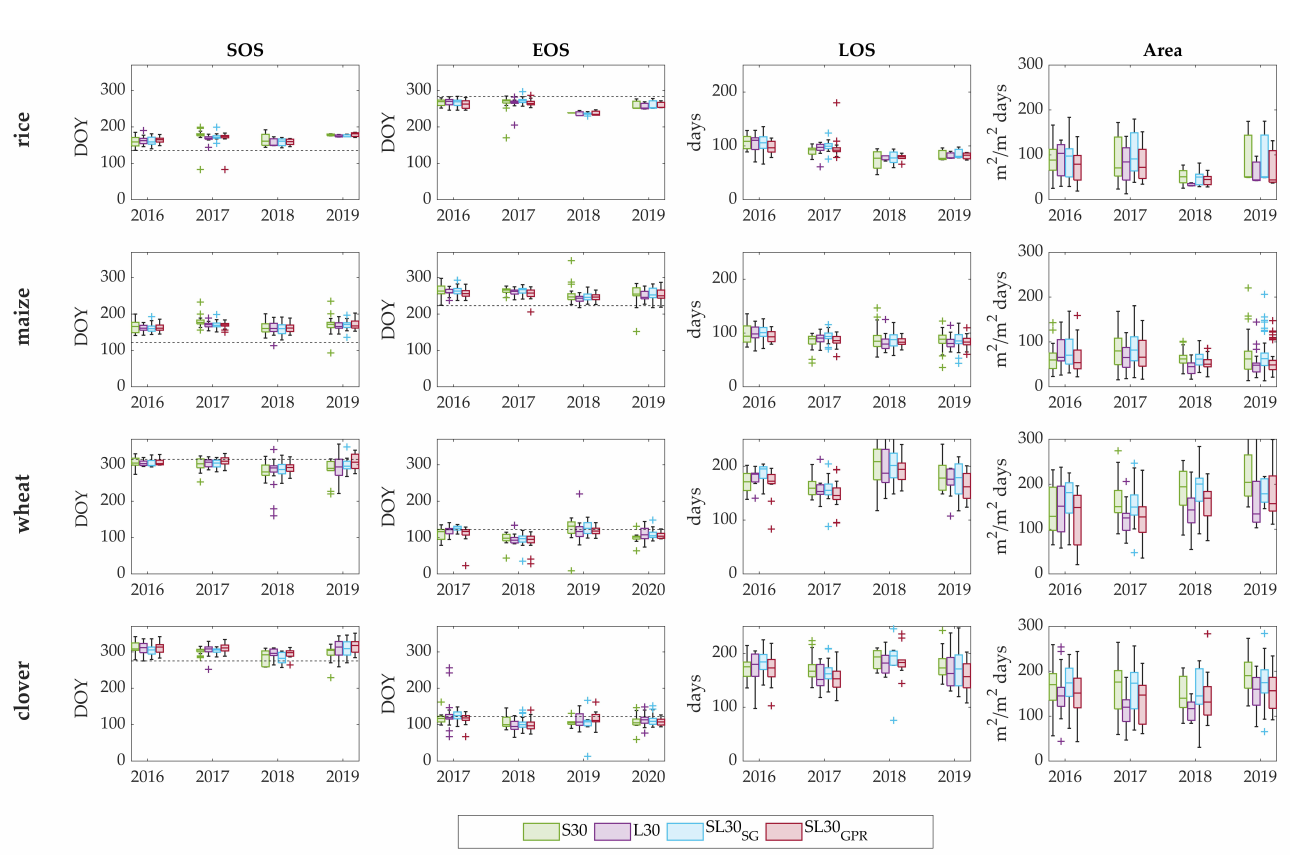
Figure 4. Temporal evolution of LSP metrics distribution of major crops (rice, maize, wheat, clover) parcels per year and time series. Horizontal dashed lines in SOS and EOS boxplots represent planting and harvest dates,